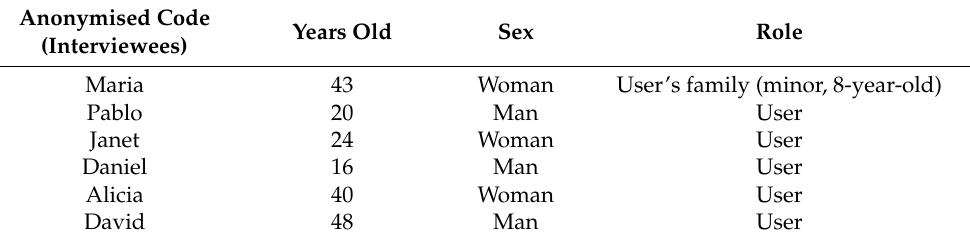
Table 1. Profiles of those interviewed in the communicative